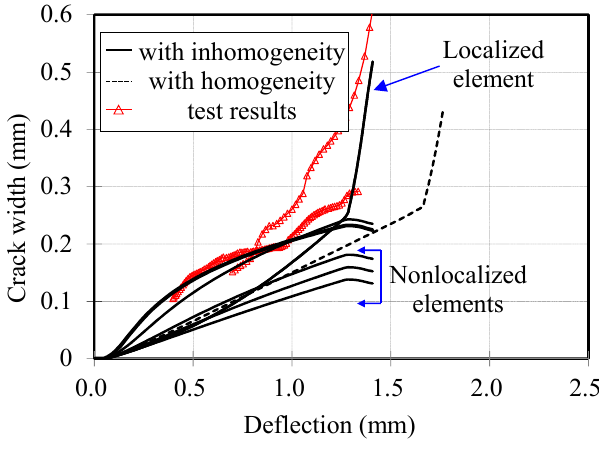
Figure 12. CMOD–deflection